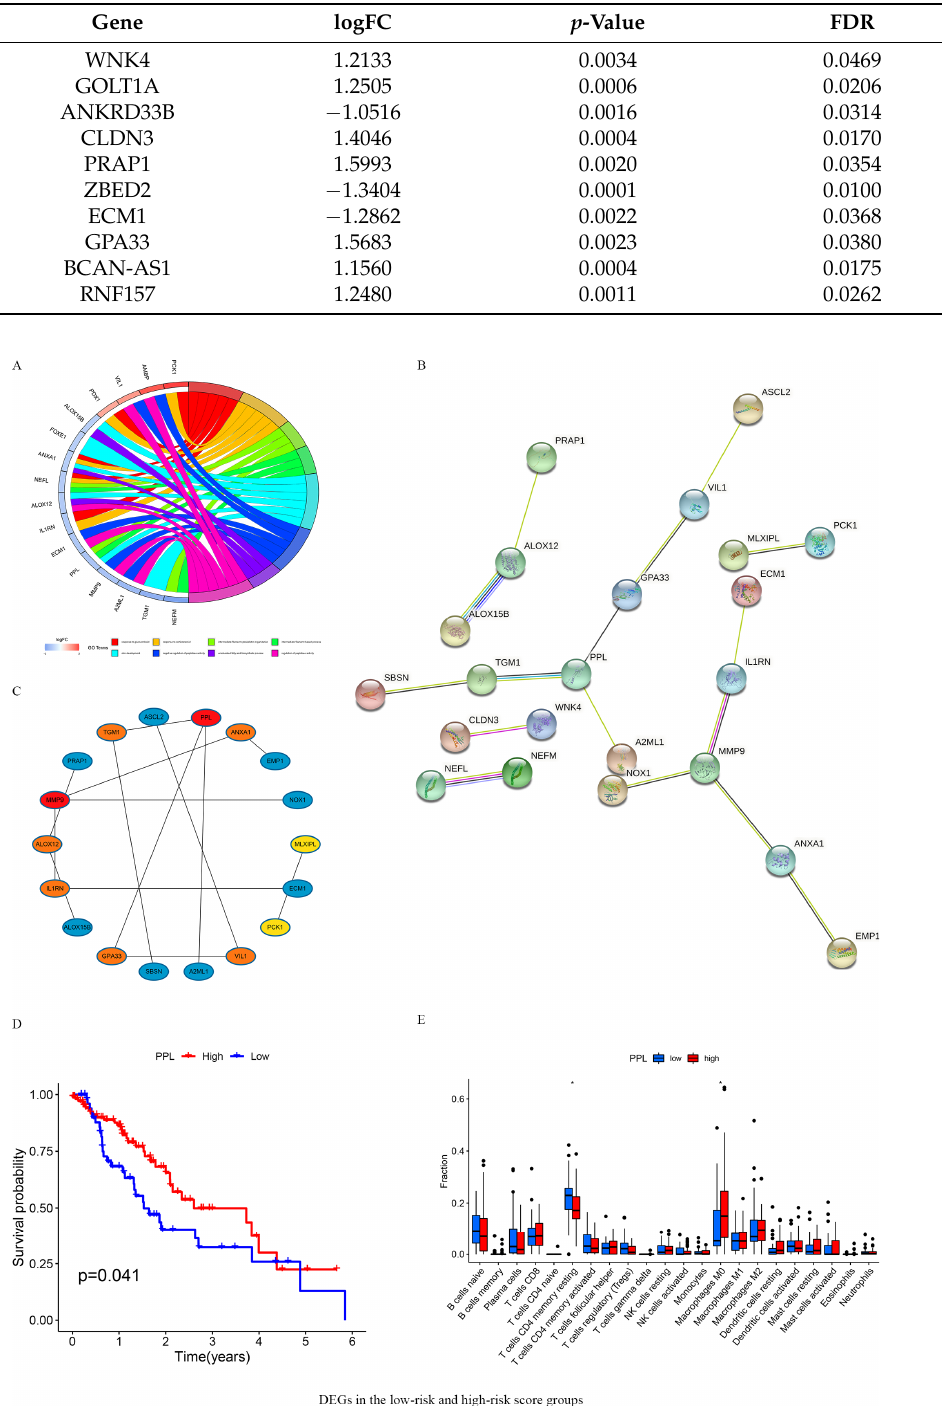
Figure 6. DEGs in the low- and high- risk score groups. ( A ) The results of GO enrichment analysis on DEGs. ( B ) PPI network processed by STRING. ( C ) Identification of 10 hub DEGs using cytoHubba software. ( D ) Survival analysis for subgroup patients stratified by PPL mRNA expression. ( E ) The abundance of each infiltrated cell in patients with high- and low PPL mRNA expression. DEGs in 160 ESCA patients between 2 different risk groups were analyzed using the Limma R package (|logFC| > 1, FDR < 0.05). Black circle represent individual values. *p < 0.05. 3.7. Validating the Expression of the Seven FRGs and Their Prognostic Value The UALCAN online database was used to analyze how the expression of key FRGs affected survival times. The results indicated that FABP2, HSPH1, and IDH3G were more abundantly expressed in tumors (Figure 7A–C). Furthermore, a higher abundance of PDHA1 correlated with poor prognosis in ESCA patients (Figure 7D). Similarly, the in- creased expression of HSPH1, IDH3G, NUDT7 and PDHA1 was associated with shorter OS in the subgroup of patients suffering from esophageal adenocarcinoma (EAD) (Figure 7E–H).